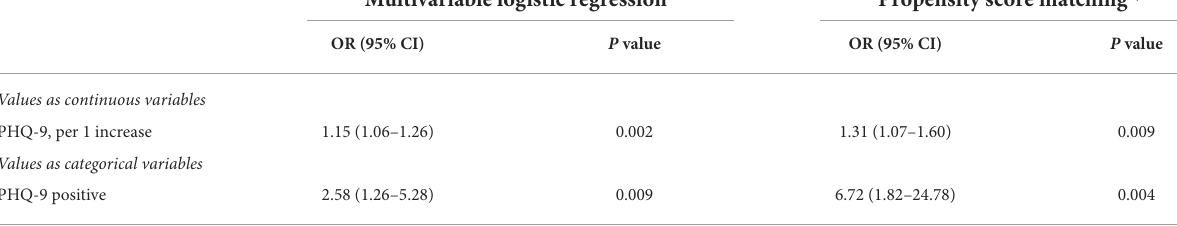
TABLE 3 PHQ-9 and poor functional outcome at 3 months.